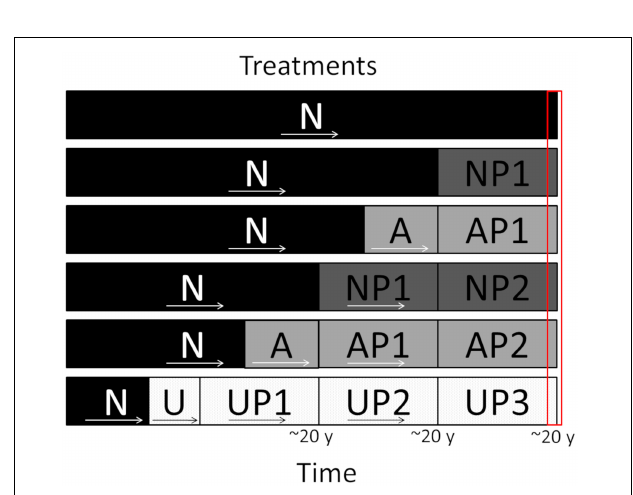
FIGURE 2 | Representation of the conditions (treatments) evaluated. Native forest (N) and pine plantations following the sequence of changes experienced by stands. First rotation pine plantation that replaced native forest (NP1), second rotation pine plantation that replaced native forest (NP2), first rotation pine plantation that replaced agricultural lands (AP1), second rotation pine plantation that replaced agricultural lands and third rotation pine plantation of unknown previous land use (UP3). Agricultural lands (A), unknown previous cover (U). Pine plantation rotations of approximately 20 years. Red rectangle represents the time when samples were collected in each stand